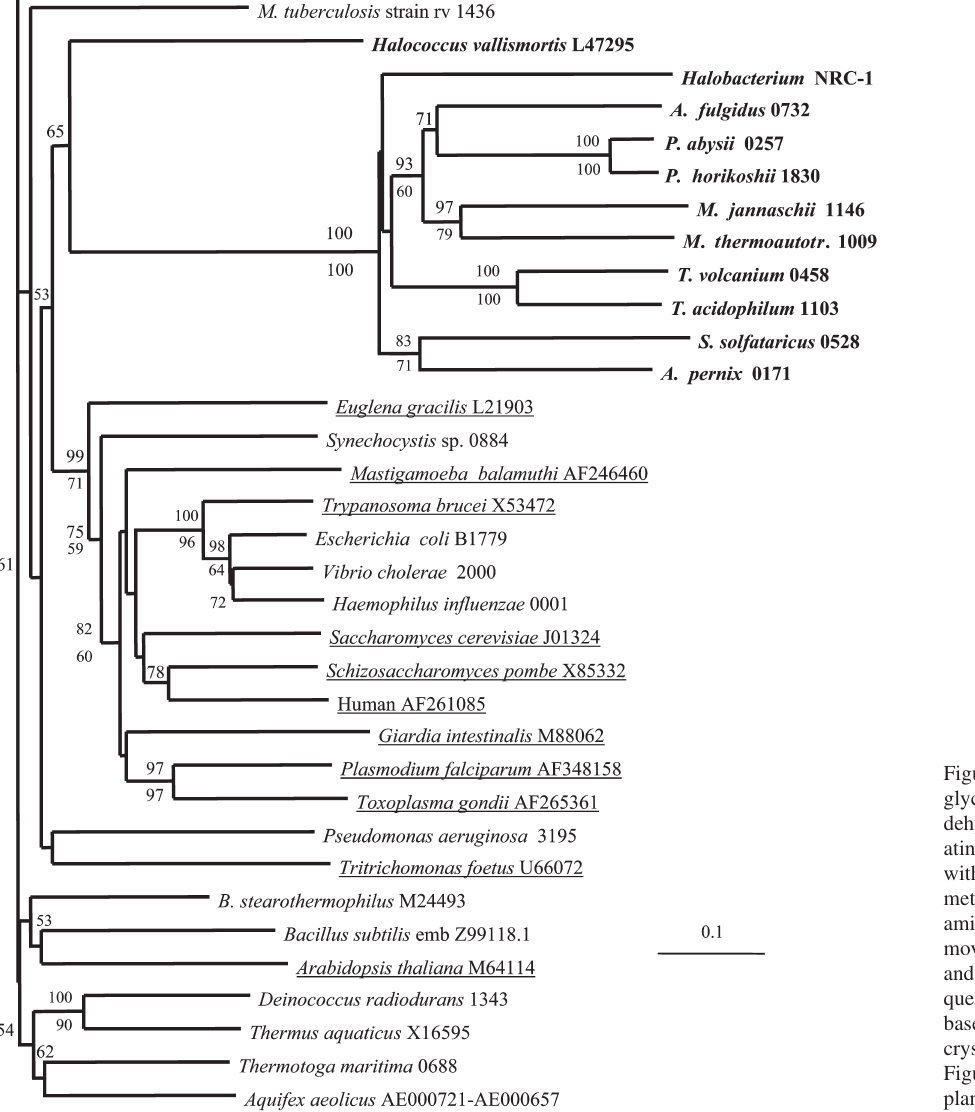
Figure 2. Phylogenetic tree of glyceraldehyde-3-phosphate dehydrogenases (phosphoryl- ating; EC 1.2.1.12) generated with the neighbor-joining method. Short stretches of amino acid residues were re- moved from the Borrelia (4) and Tritrichomonas (11) se- quences to maintain alignment based on comparison with crystal structure data. See Figure 1 caption for further ex-